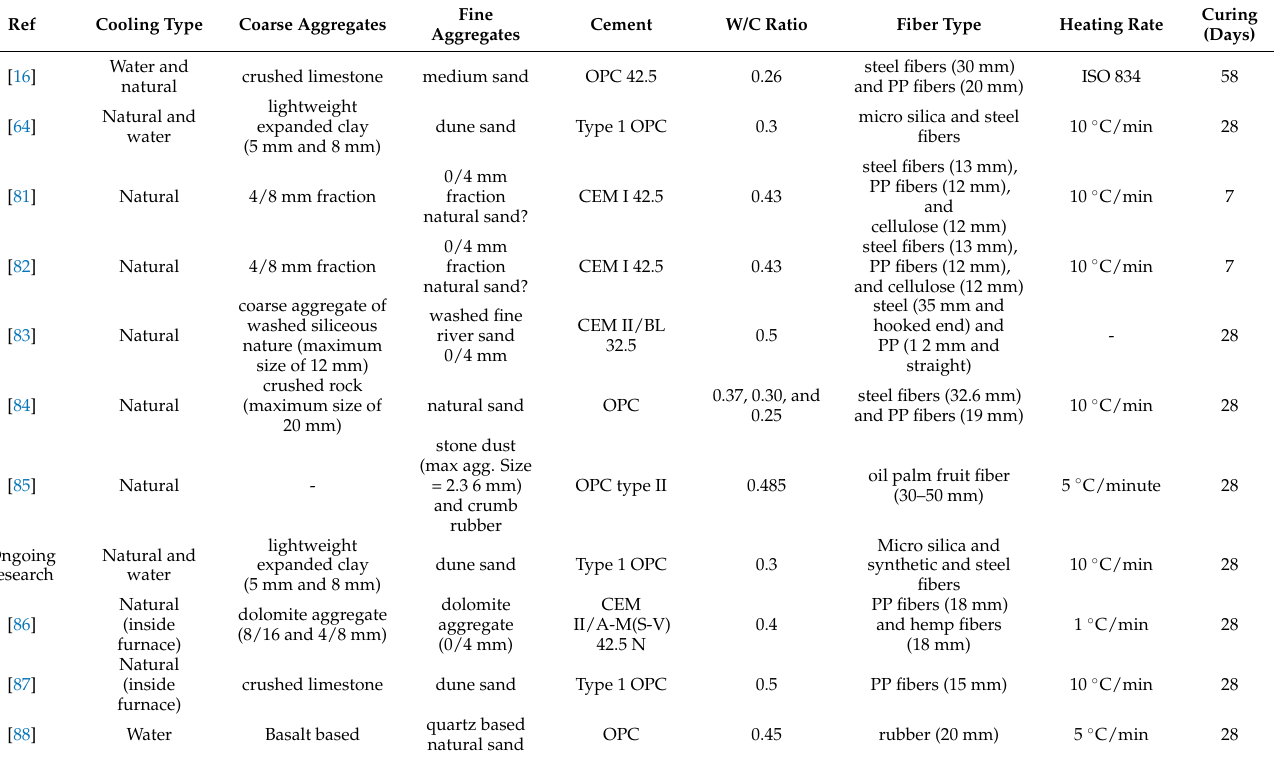
Table 4. Important parameters of different studies on FRC [16,64,81–88].